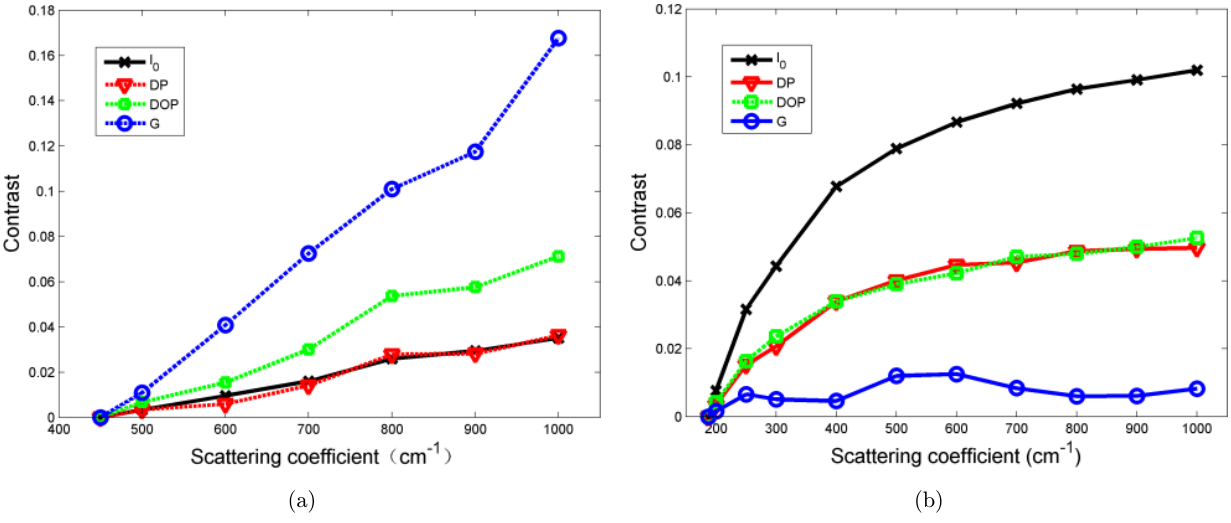
Fig. 7. Monte Carlo simulated relative contrasts of four imaging parameters: intensity, DP, DOP, RLPI parameter G at di®erent scattering coe±cients for a two-layer structure with top isotropic layer and bottom anisotropic layer. (a) The scattering coe±cient varies from 450 to 1000 cm (cid:1) 1 in top layer, (b) The scattering coe±cient varies from 187.5 to 1000 cm (cid:1) 1 in bottom